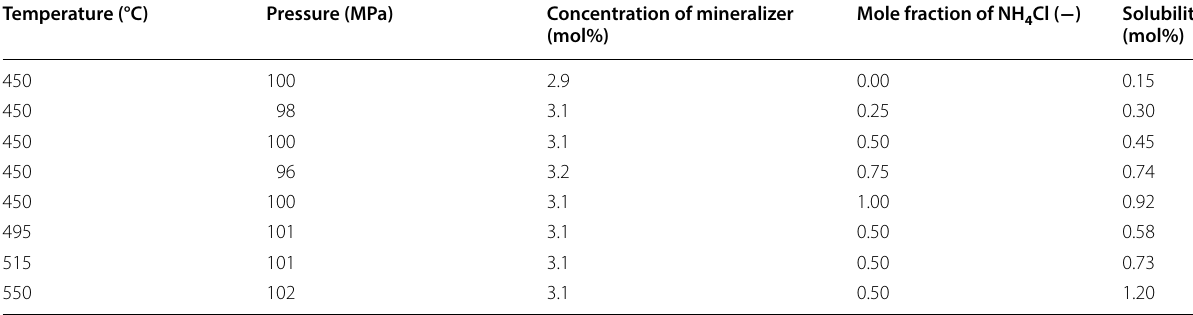
Cl NH I mixed mineralizer 4 4 +